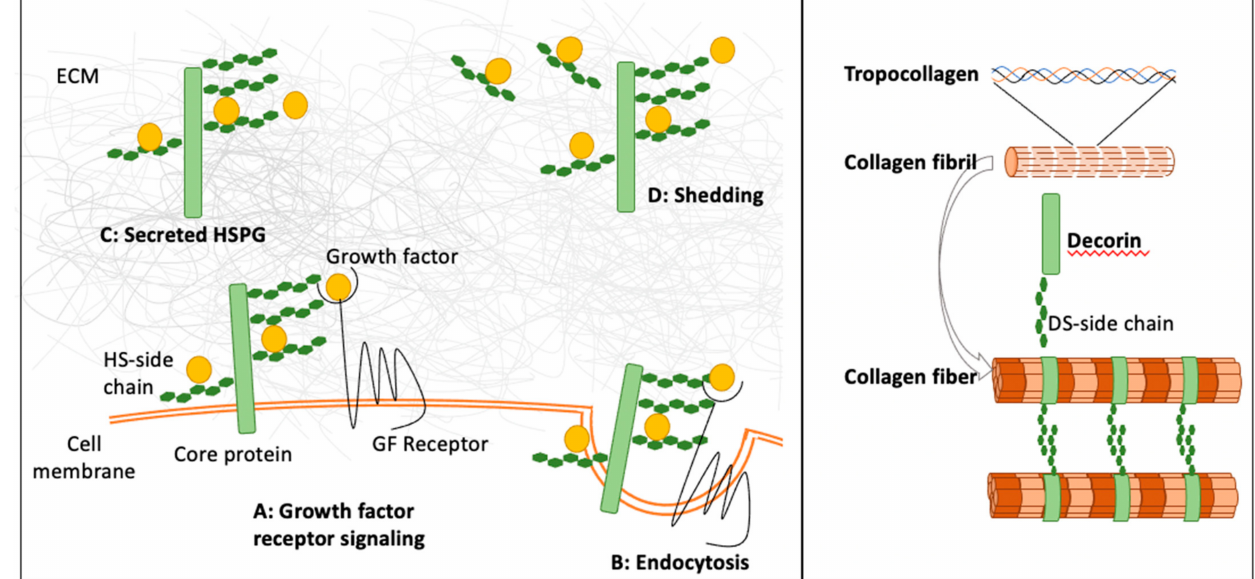
Figure 2. Examples of the biological functions of DS- and HS-containing proteoglycans. ( Left panel ) HSPGs affect growth factors and morphogens in a number of ways that are dependent on their sulfation pattern, their cellular localization, and the core protein [76]. HSPGs can be tethered to the cell surface (syndecan and glypicans), where they retain growth factors and activate receptor signaling (A), or mediate clearance of growth factors by endocytosis of growth factors and their receptors (B). HSPGs promote and stabilize the ternary complex between the growth factor, HS, and growth factor receptor. The formation of the ternary complex is enhanced by higher sulfation levels. Other HSPGs (perlecan and agrin) are secreted and localized in the ECM, where they can trap growth factors, and thus generate growth factor reservoirs and prevent their diffusion (C). HSPGs and HS can also be released by shedding, and thus become soluble (D). Soluble HSPGs can facilitate growth factor dispersal or movement through the extracellular space. ( Right panel ) During collagen fibrillogenesis, procollagen is synthesized as a triple helix that self-assembles into striated collagen fibrils after cleavage of the C- and N-terminal propeptides. The collagen fibrils are then arranged into uniform collagen fibers. The precise spacings between collagen fibers are maintained by the DS-containing proteoglycan